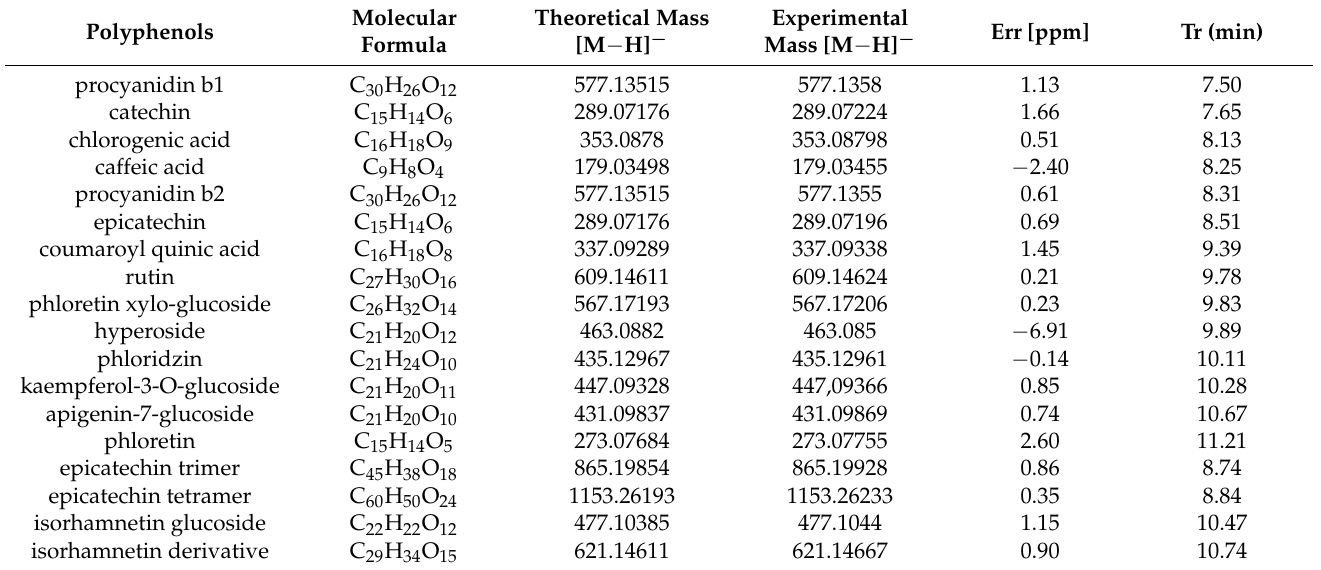
Table 3. Retention time and exact mass spectra data of apple polyphenols investigated by UHPLC-HRMS Orbitrap.